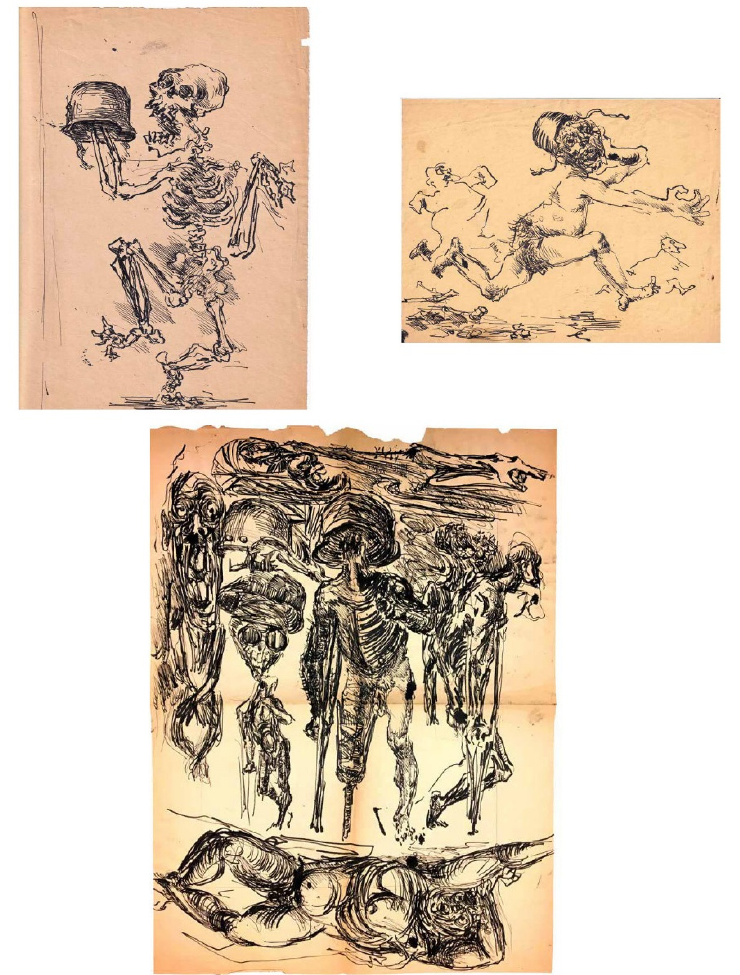
Figure 1. Robert Mallary, a selection of Mexico City drawings, 1936–1943. Photographs courtesy of Mitchell Algus Gallery, New York (drawings are not shown to scale).